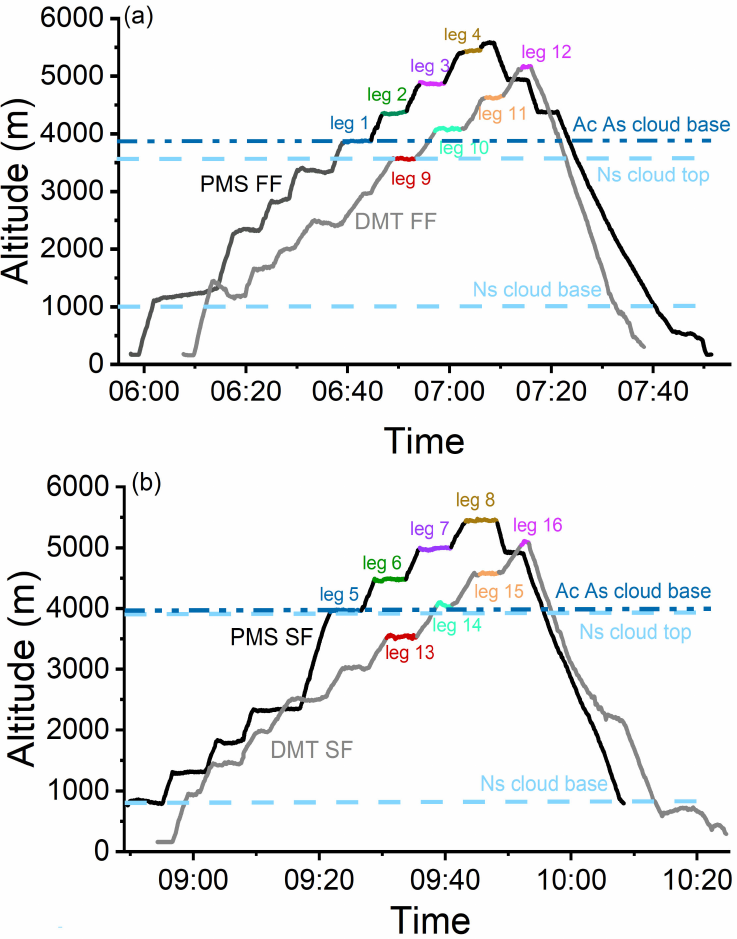
Figure 2. Detection flight trajectories: Time–Altitude diagram: ( a ) black: PMS FF, gray: DMT FF ( b ) black: PMS SF, gray: DMT SF. Table 2. Horizontal flight leg features including aircraft, beginning and end times, altitude, and cloud